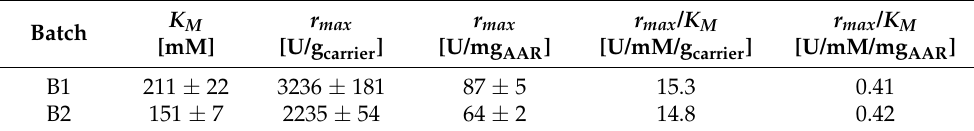
Figure 2. Initial reaction rates (determined after 10% conversion) with respect to the amount of ( a ) the AAR and ( b ) the immobilization carrier for both batches B1 (grey cross) and B2 (black circle) for L -Met in pure water at 20 °C. The three green triangles represent the values of three individual column with carrier from B2, which were packed within a time span of three weeks (day 1: dark green, day 9: medium green, day 24: light green). Table 2. Kinetic parameters of immobilized amino acid racemase (AAR) from two batches in pure water for L -Met, Equation